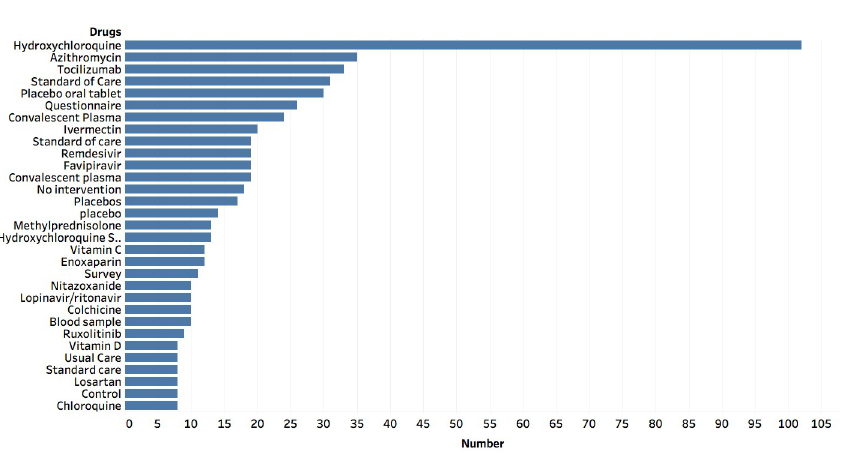
Fig 2. Intervention/Drug information. The graph shows the relative frequency of the different intervention/drugs that are referenced in COVID-19 related clinical trials (August 2020). A minimum occurrence of 8 clinical trials was used to create the graph.